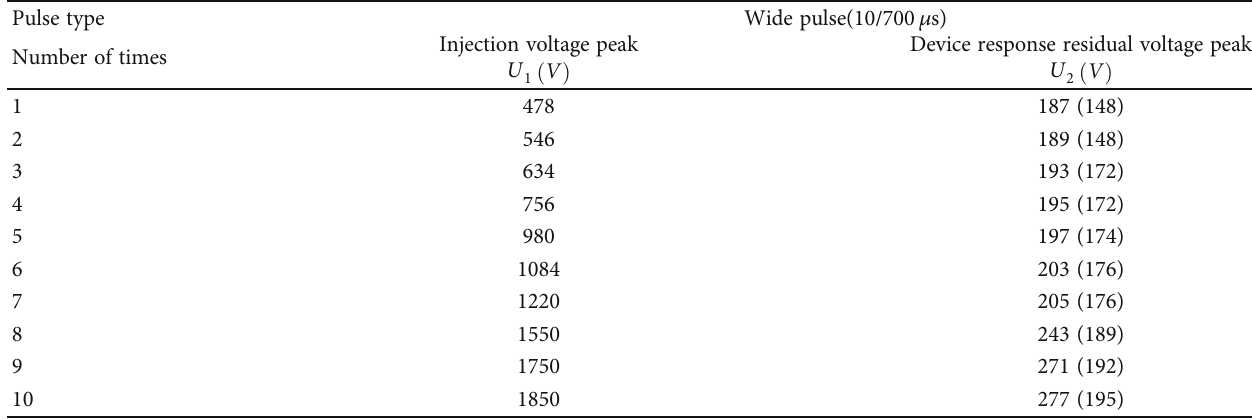
Figure 9: Response waveform of TVS to wide pulse. Table 6: Test results of TVS ’ s ability to suppress wide pulse (TVS type is